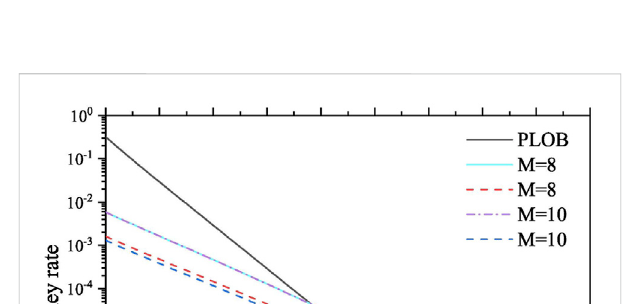
FIGURE 1 Results of the secret key rate versus channel loss for Protocol I withdifferent M values.TheblacklinerepresentsthePLOBbound,and thecurvesfromthebottomtothetoprepresentthesecretkeyratesof Protocol I with M = 4, 6, 8, and 10.